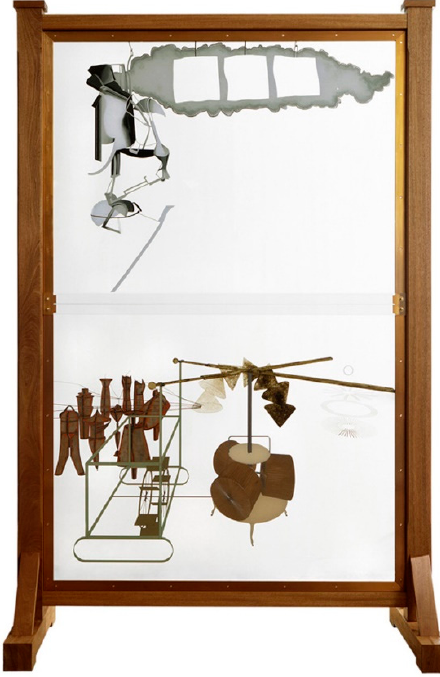
Figure 1. The Large Glass (The Bride Stripped Bare by Her Bachelors, Even) by Marcel Duchamp, 1915–1923; 2nd version 1991–1992. Oil on lead sheet, lead wire, dust and varnish on broken glass plates, glass plates, aluminum foil, wood, steel, 277.5 cm × 175.9 cm. Moderna Museet , Stockholm. © succession Marcel Duchamp/ADAGP, Paris 2014 and used by permission.